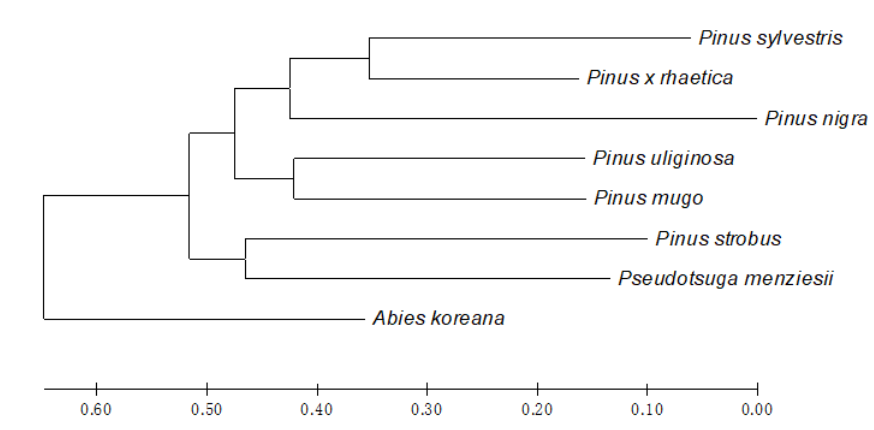
Figure 4. Evolutionary relationships of the Pinaceae taxa under study. The evolutionary history was inferred using the Neighbor-Joining method (NJ), based on the Jaccard distance (JD). The optimal tree with the sum of the branch length = 2.82700000 is shown. The tree is drawn to scale, with the branch lengths in the same units as those of the evolutionary distances used to infer the phylogenetic tree. Evolutionary analyses were conducted in MEGA X [43].